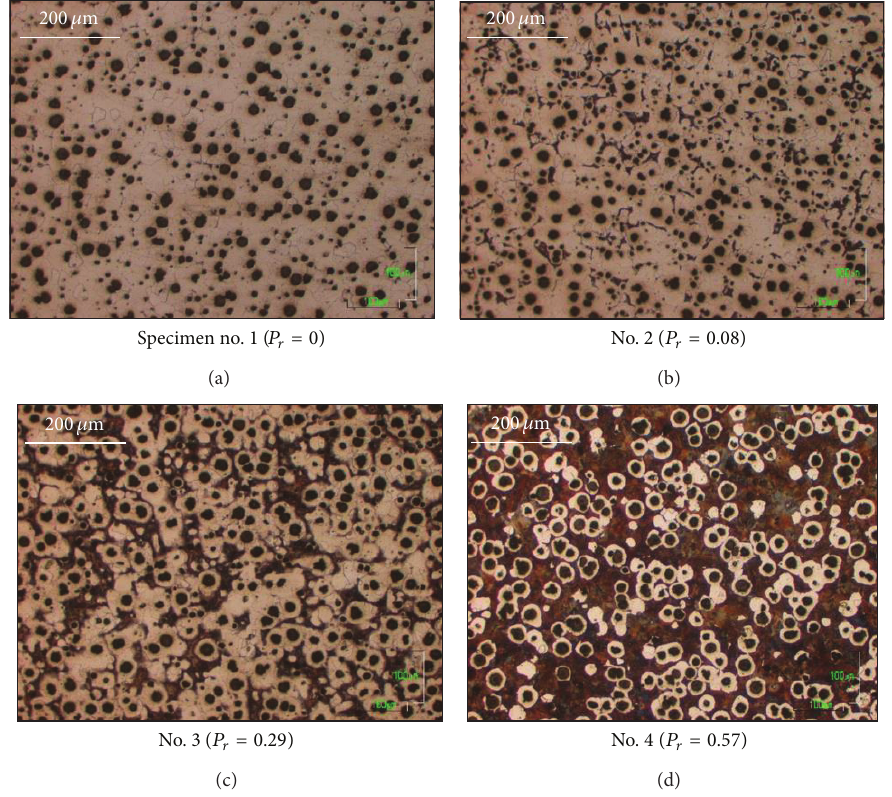
Figure 3: Microscopic photographs of the specimens.